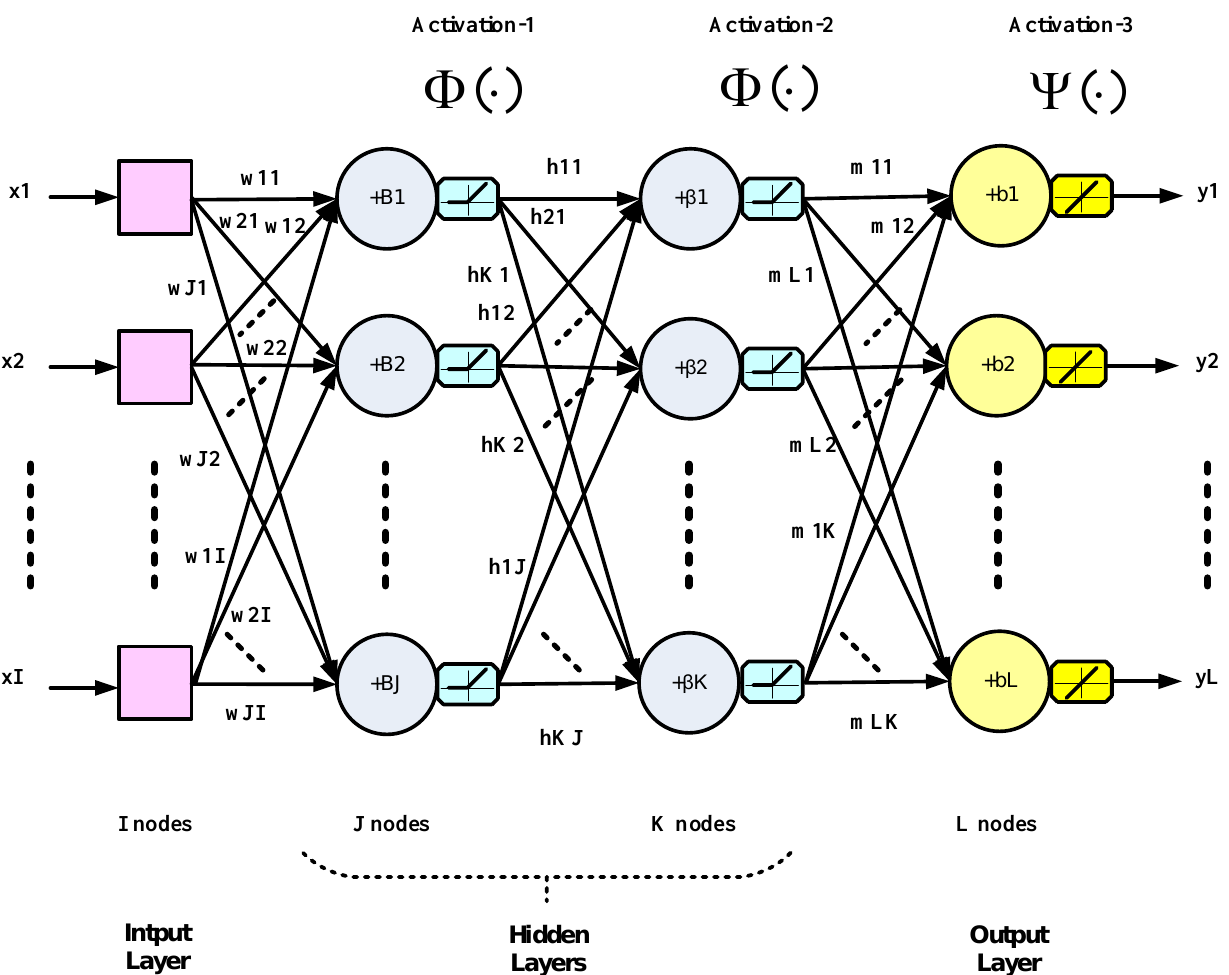
Figure 1. A generic diagram for a three-layer deep NN (neural network) with two hidden layers.